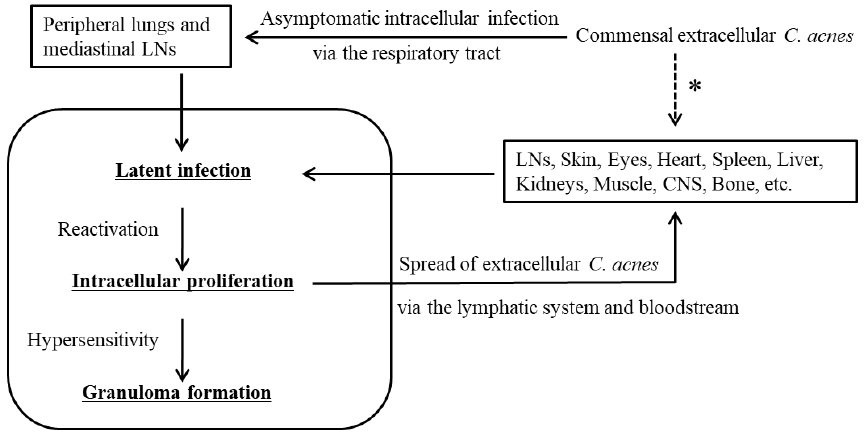
Figure 5. Assumed pathogenesis of sarcoidosis caused by C. acnes . Granuloma formation occurs only in some predisposed individuals with Th1 hypersensitivity against the intracellular prolifera- tion of C. acnes reactivated at the sites of latent infection. Extracellular C. acnes after intracellular proliferation potentially causes new latent infection in the same or other organs. LNs, lymph nodes; CNS, central nervous system. * Local entry and subsequent latent infection of C. acnes other than the systemic spread may occur in some organs or patients. The figure is original and was previously published [35].